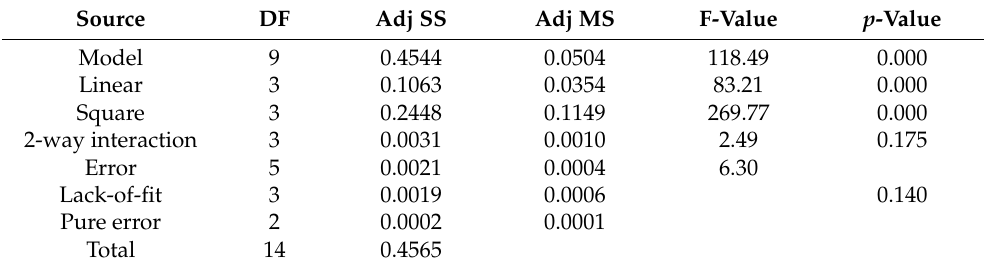
Table 4. ANOVA for SR in